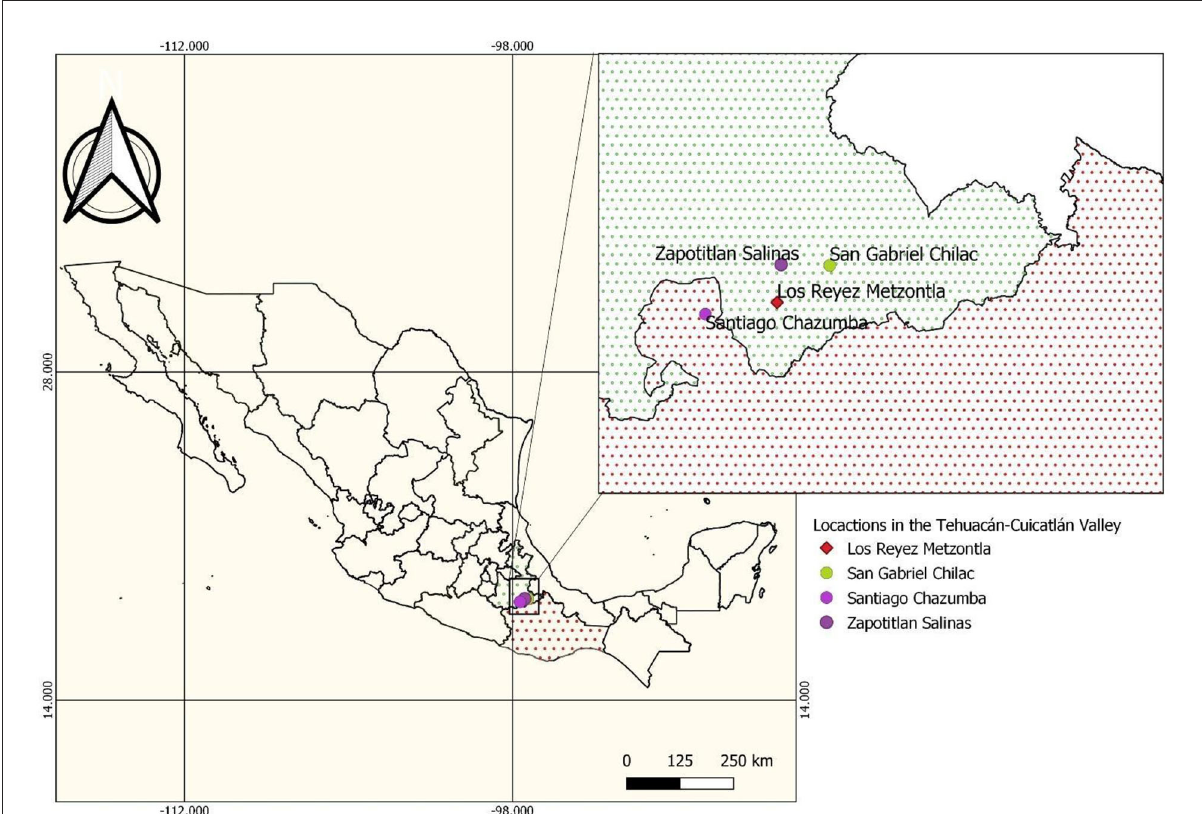
FIGURE1 Study area in Mexico, doted locations comprise states where the study was performed (red for Oaxaca and green for Puebla). Purple points represent sites where tolonche production was recorded, the green point is the locality where lapo production was recorded, and the red point represents the locality where pulque and fermentation containers are produced. The map was elaborated with open-source software, Qgis3.4, https://qgis.org/es/site/. Source: INEGI conjunto de datos